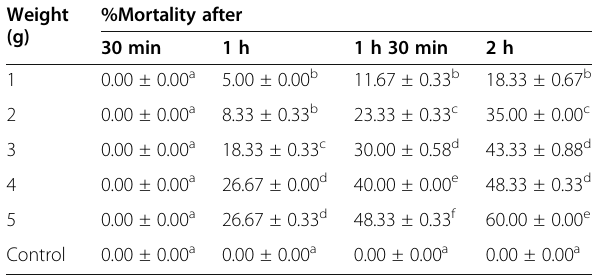
Table 1 Fumigant toxicity of Leaf powder of Petiveria alliacea on the mortality of adult Culex quinquefasciatus Weight %Mortality after (g)